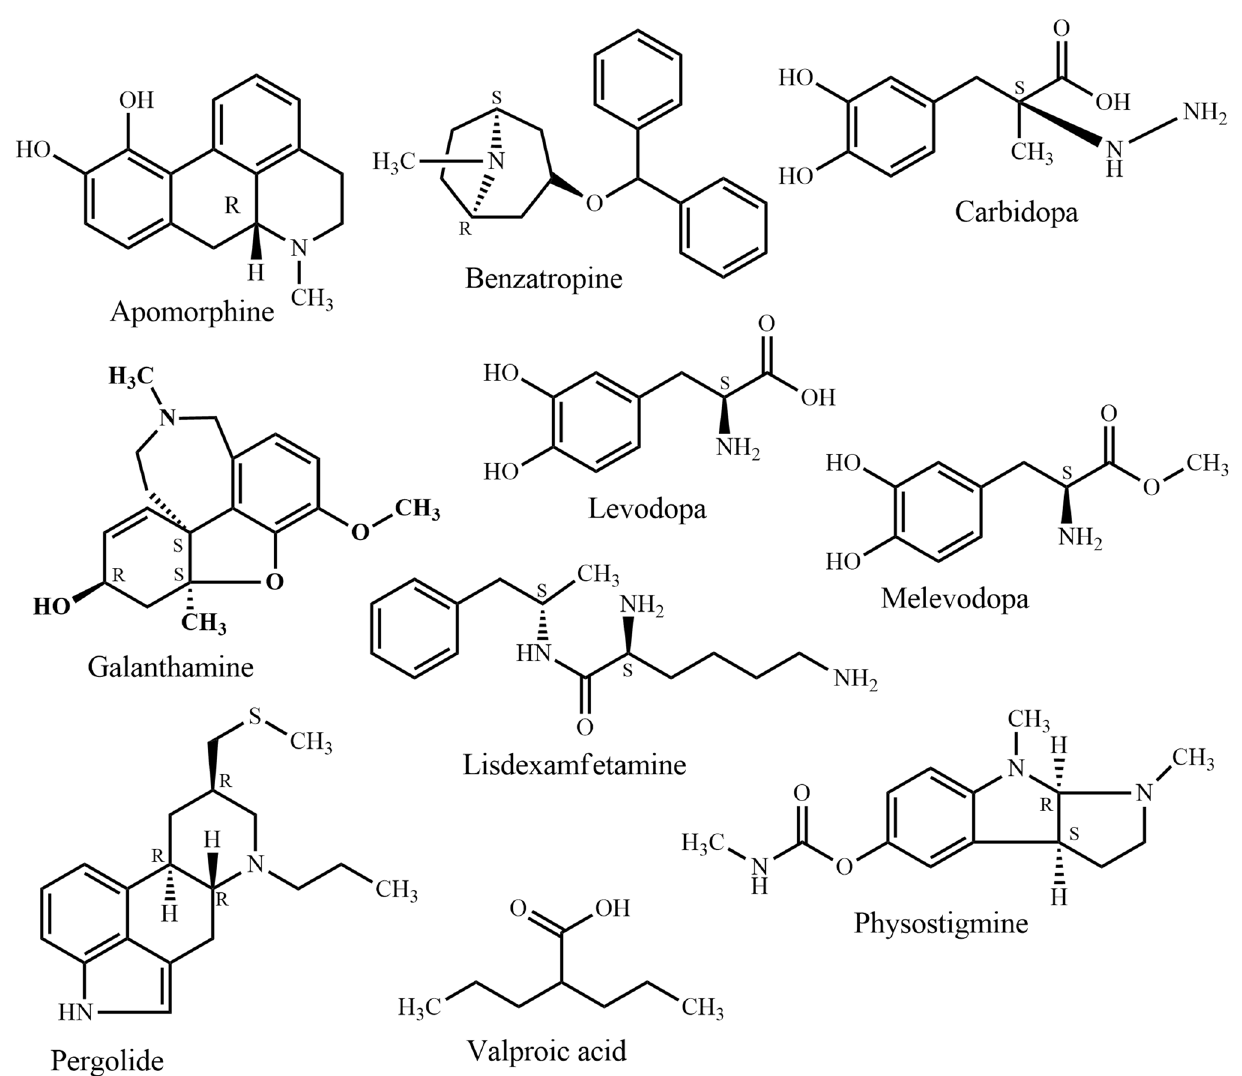
Fig. 4 Chemical structure of some commonly used natural products for the treatment of nervous system disorders